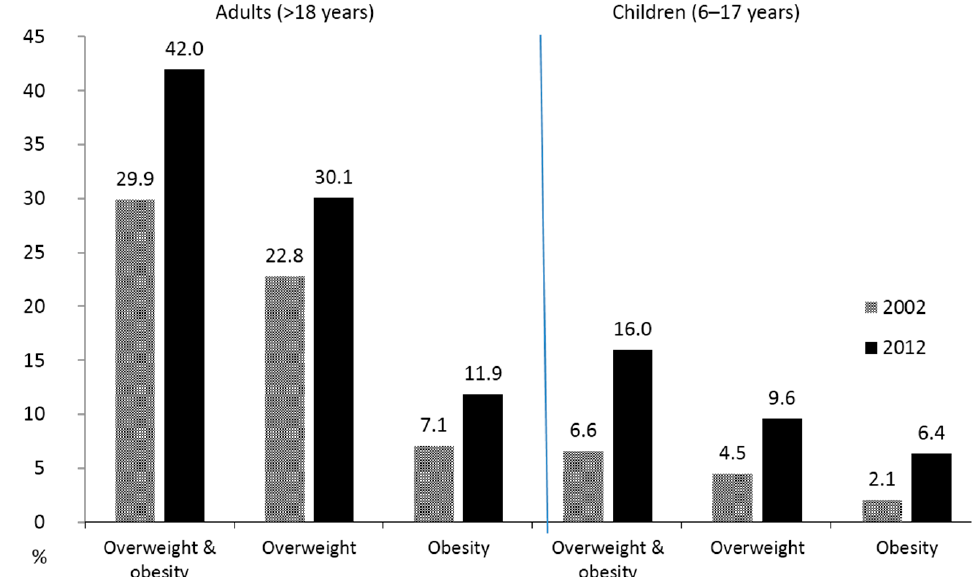
Figure 2. Increase of prevalence (%) of overweight and obesity in China among adults and children from 2002 to 2012. Based on national representative data and Chinese BMI cut points, e.g., for adults, 24 < BMI < 28 for overweight, and BMI>28 for obesity; for children, age-sex-specific BMI cut points were used.